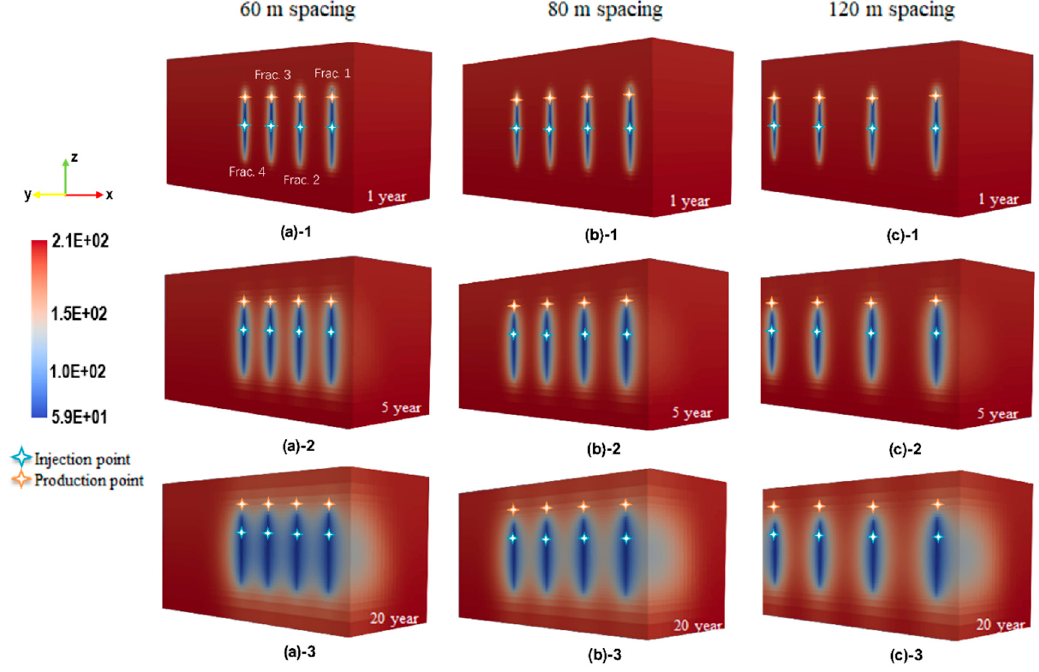
Figure 7. Spatial distribution of temperature variation after 1, 5, and 20 years of production with (a) 60, (b) 80, and (c) 120 m fracture spacing in the developed model.